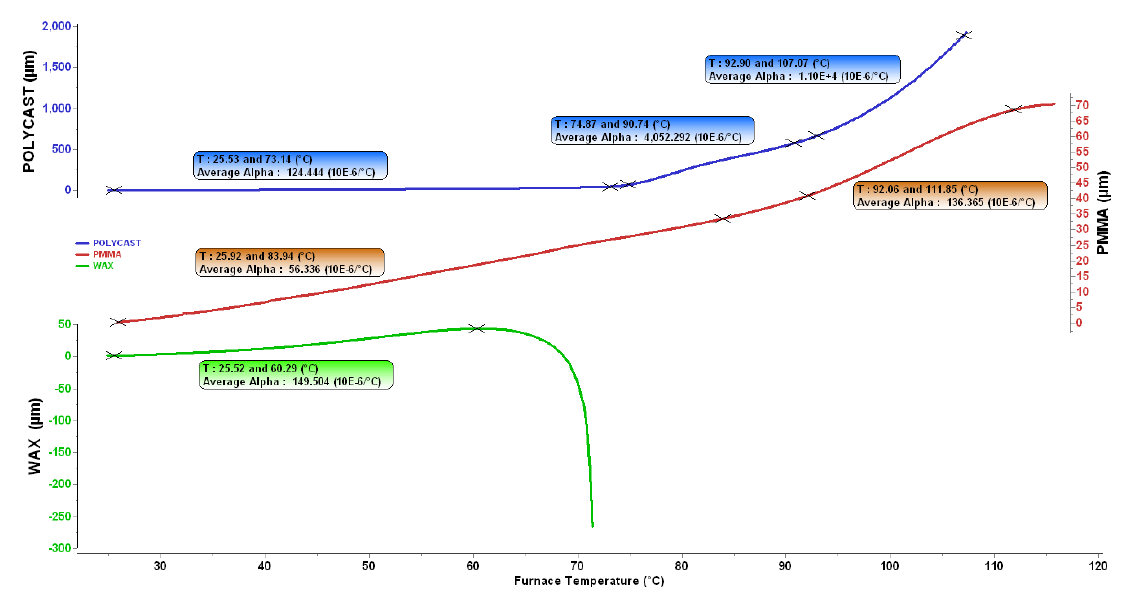
Figure 9. Elongation of samples depending on temperature.